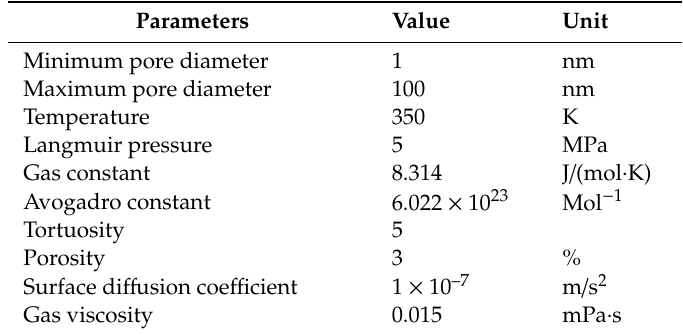
Table 2. Basic input parameters of the shale apparent permeability